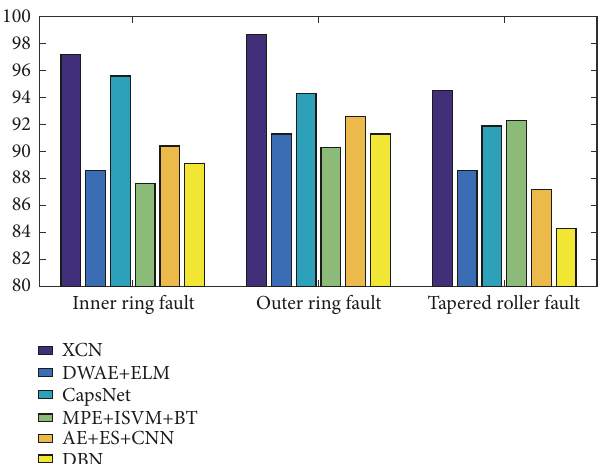
Figure 17: Average classification accuracy of different algorithms based on the test bearing data set of wind turbine gearbox in actual working